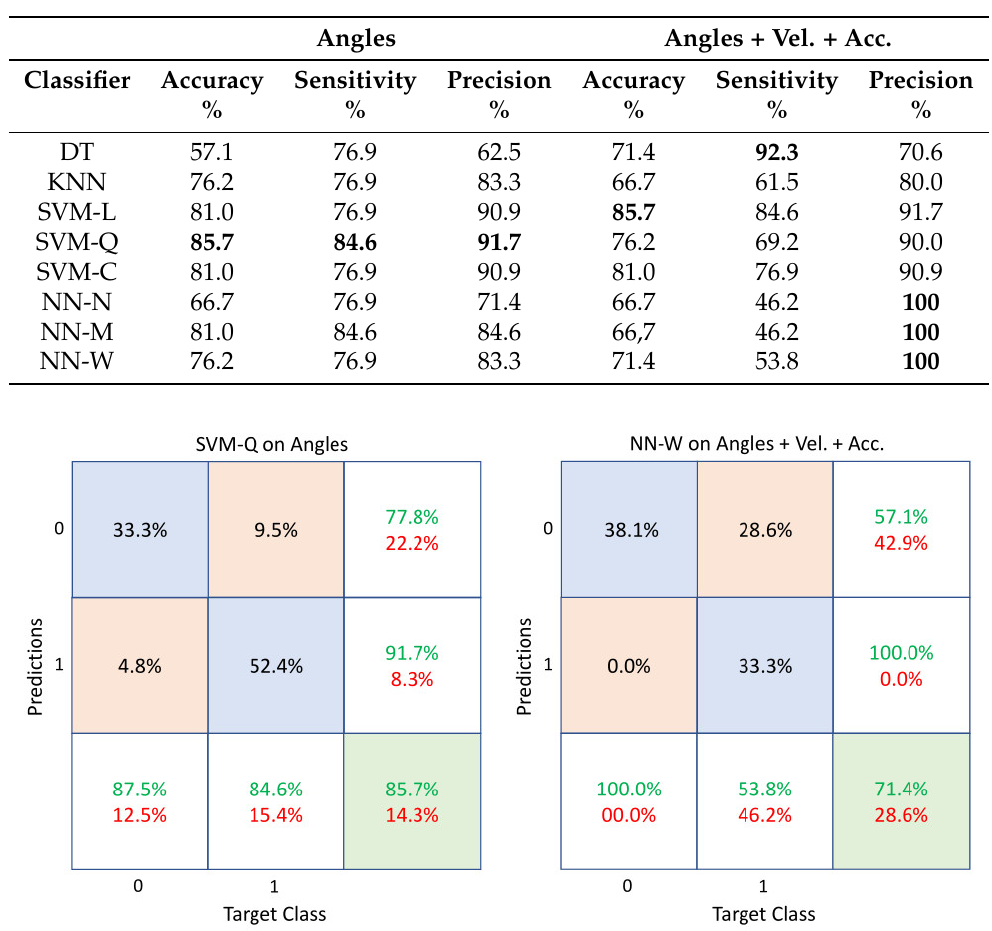
Table 3. Classification results when angles ( A a , i ) and angles plus velocity ( A (cid:48) were used as feature vectors. The maximum percentages are highlighted in bold.